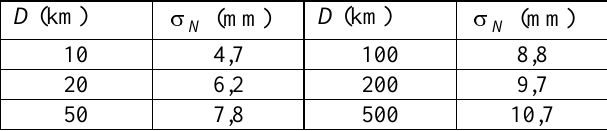
Table 2. The aliasing error in Estonia as a function of geoid support point separation